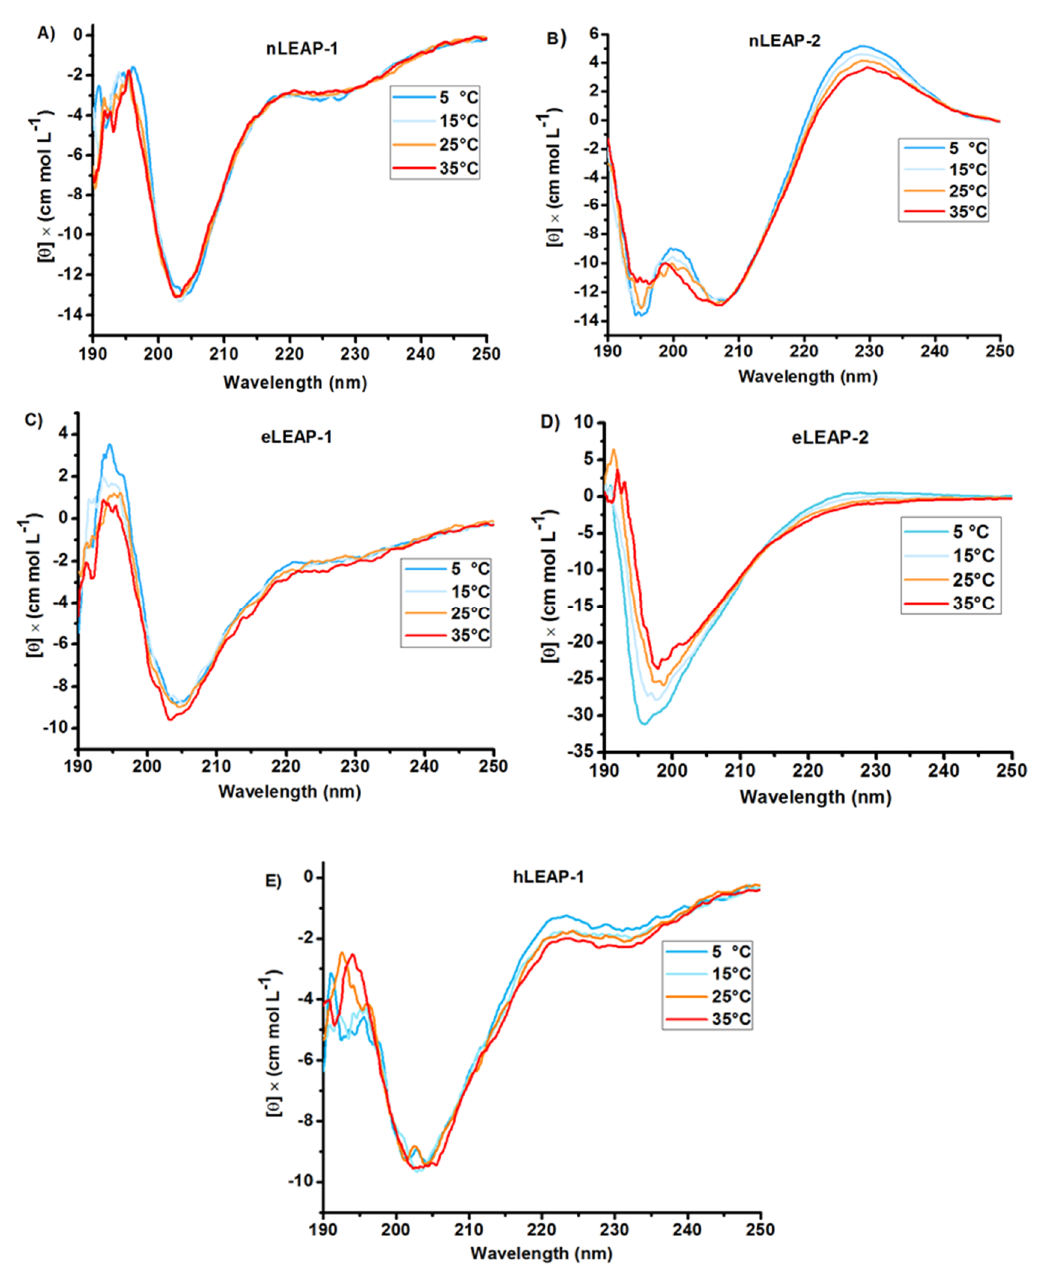
Figure 2. Representative CD spectra of LEAPs with temperature-dependent changes in ( A ) nLEAP-1, ( B ) nLEAP-2, ( C ) eLEAP-1, ( D ) eLEAP-2 and ( E ) hLEAP-1 at 5, 15, 25 and 35 °C. The CD spectra were recorded in structure-promoting solvent system trifluoroethanol, pH 7.4 (TFE, 30% v / v in water). The values from five independent scans were averaged per sample.